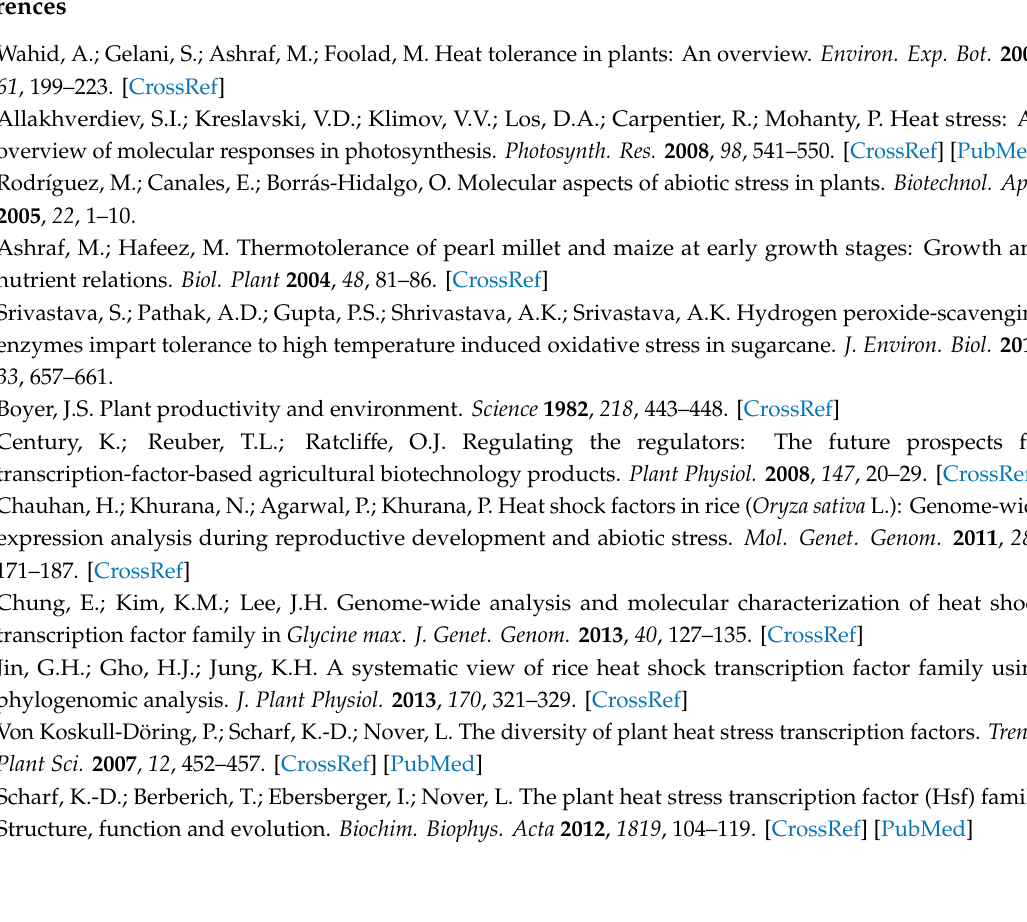
Table S1: Amino acid sequences of Hsf proteins in all the genomes tested. Table S2: Primers used to detect the expression of tea Hsf genes in this